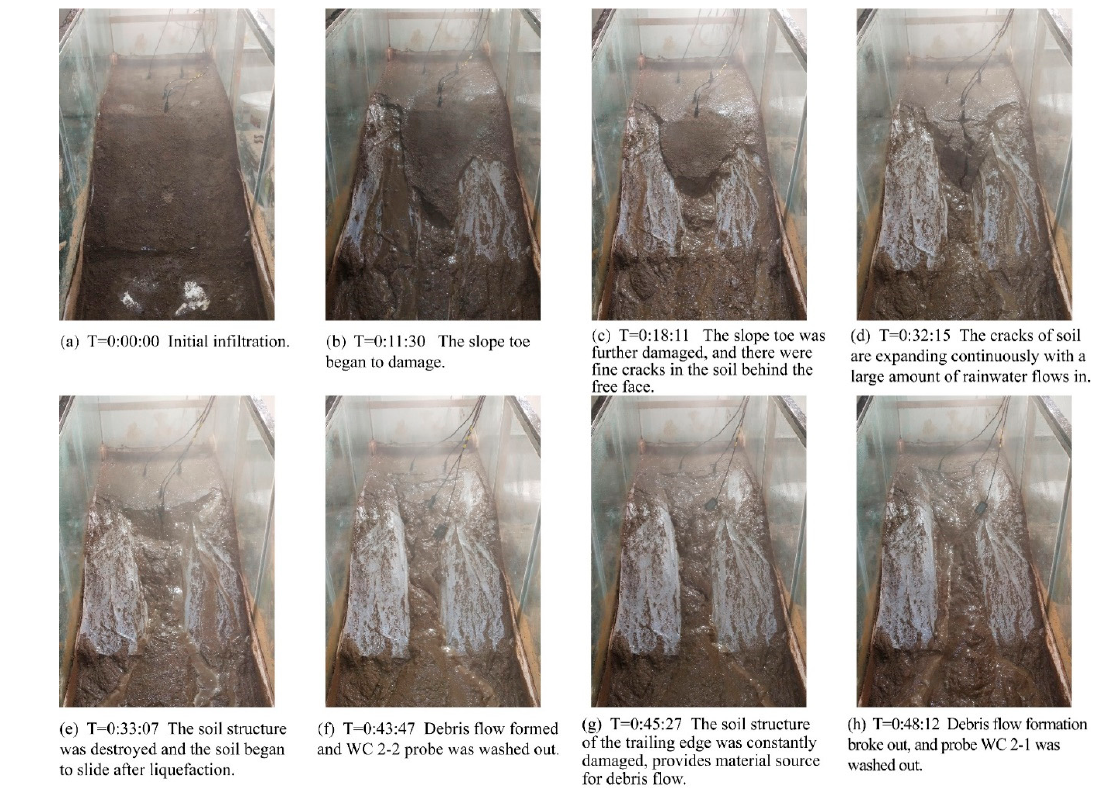
Figure 11. Damage characteristics of ZJCG condition under rare extraordinary rainstorm (109.15 mm/h).